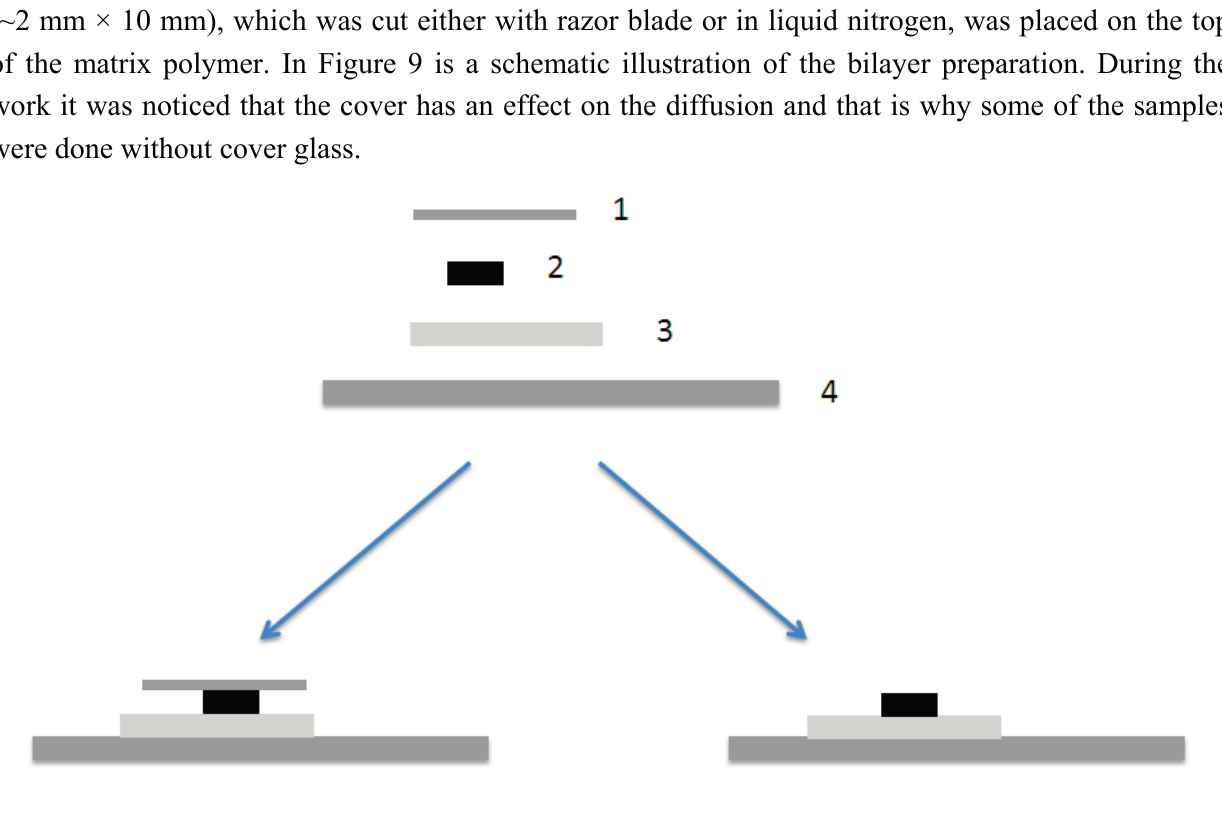
Figure 9. A schematic illustration of the bilayer preparation. (1) Cover glass, (2) P3DDT-film, (3) matrix (EVA)-film and (4) microslide. On the left sample with cover glass and on the right without